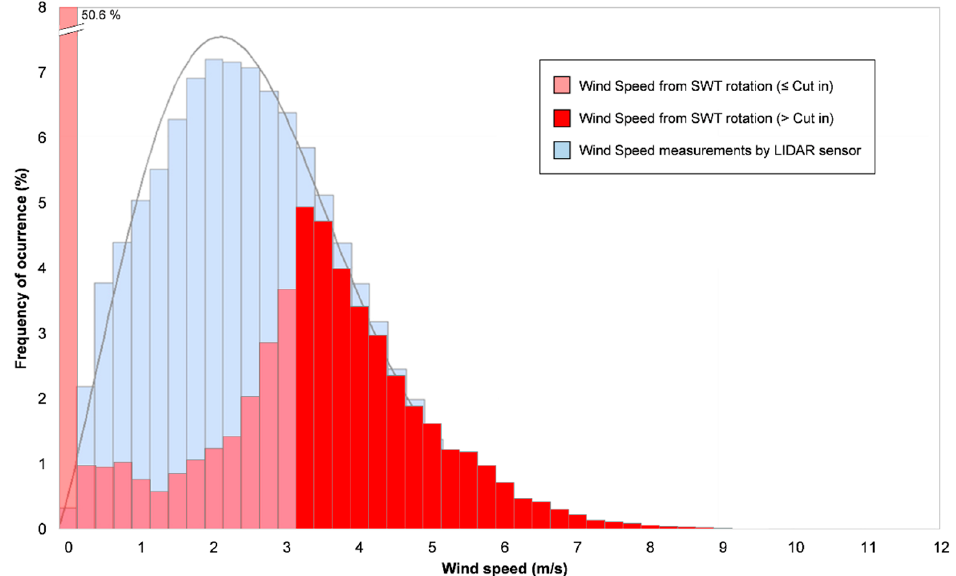
Figure 16. Superposition of the wind frequency distribution measured by the SWT wind speed estimation with the Lidar sensor.